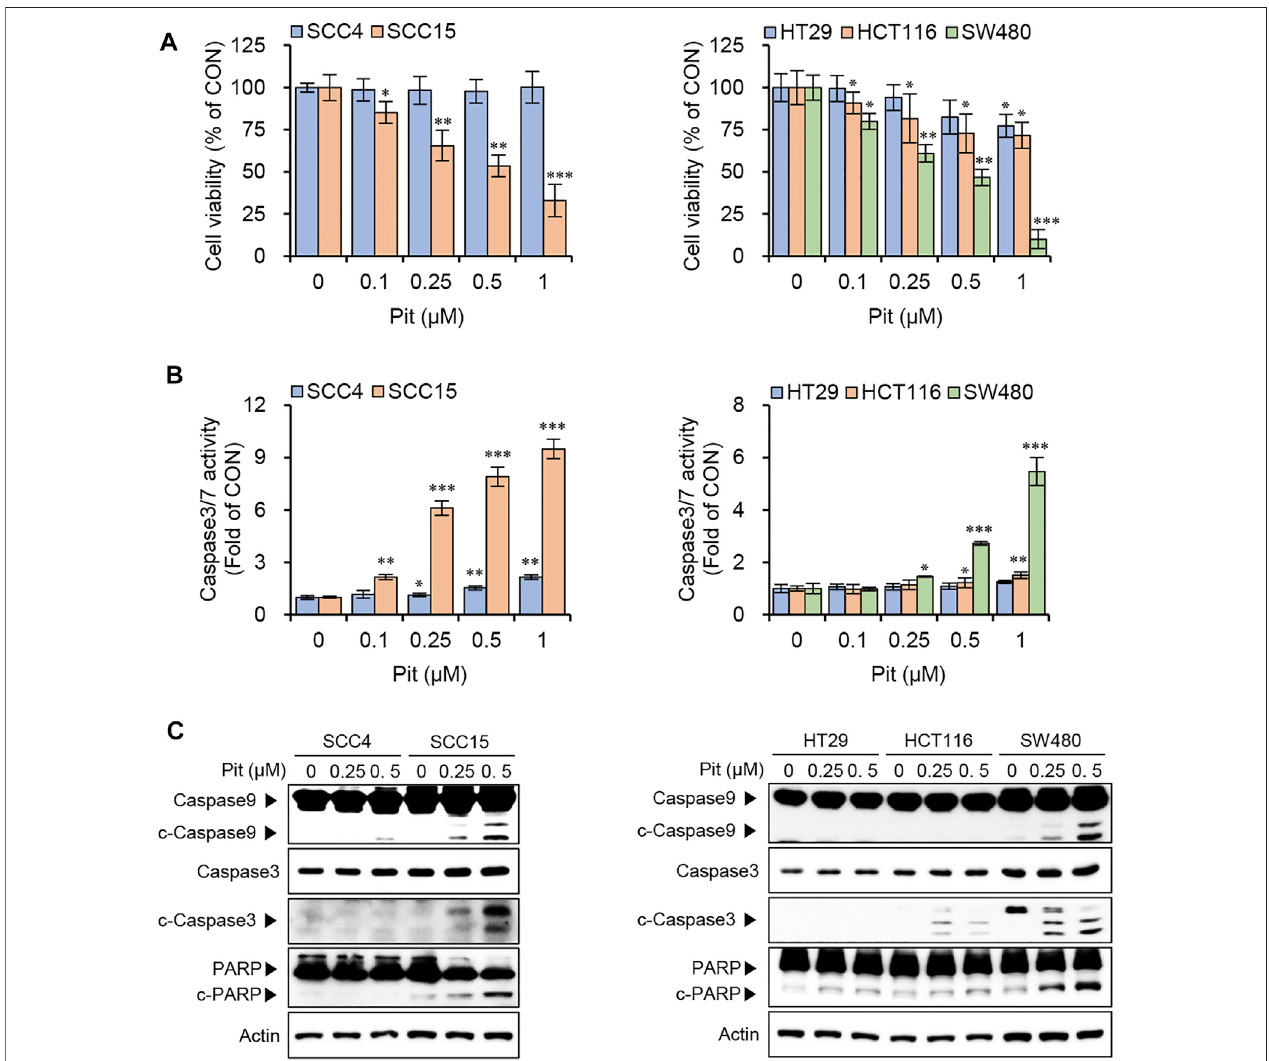
FIGURE 1 | Pitavastatin induces apoptosis in SCC15 and SW480 cells. (A) Cells were seeded onto 96-well plates (1.5 × 10 3 cells/well) and treated with various concentrationsofpitavastatinfor48 h.CellviabilitiesweremeasuredusingtheCytoTox-Glocytotoxicityassaykit.StatisticalanalysiswasperformedusingtheStudent ’ s t -test. Error bars represent mean ± SD ( n = 4). * p < 0.05; ** p < 0.01; *** p < 0.001. (B) Cells seeded at a density of 1.5 × 10 3 cells/well were treated with pitavastatin for 48 h and caspase 3/7 activity was measured using the Caspase 3/7 Glo assay kit. Statistical analysis was performed using Student ’ s t -test. Error bars